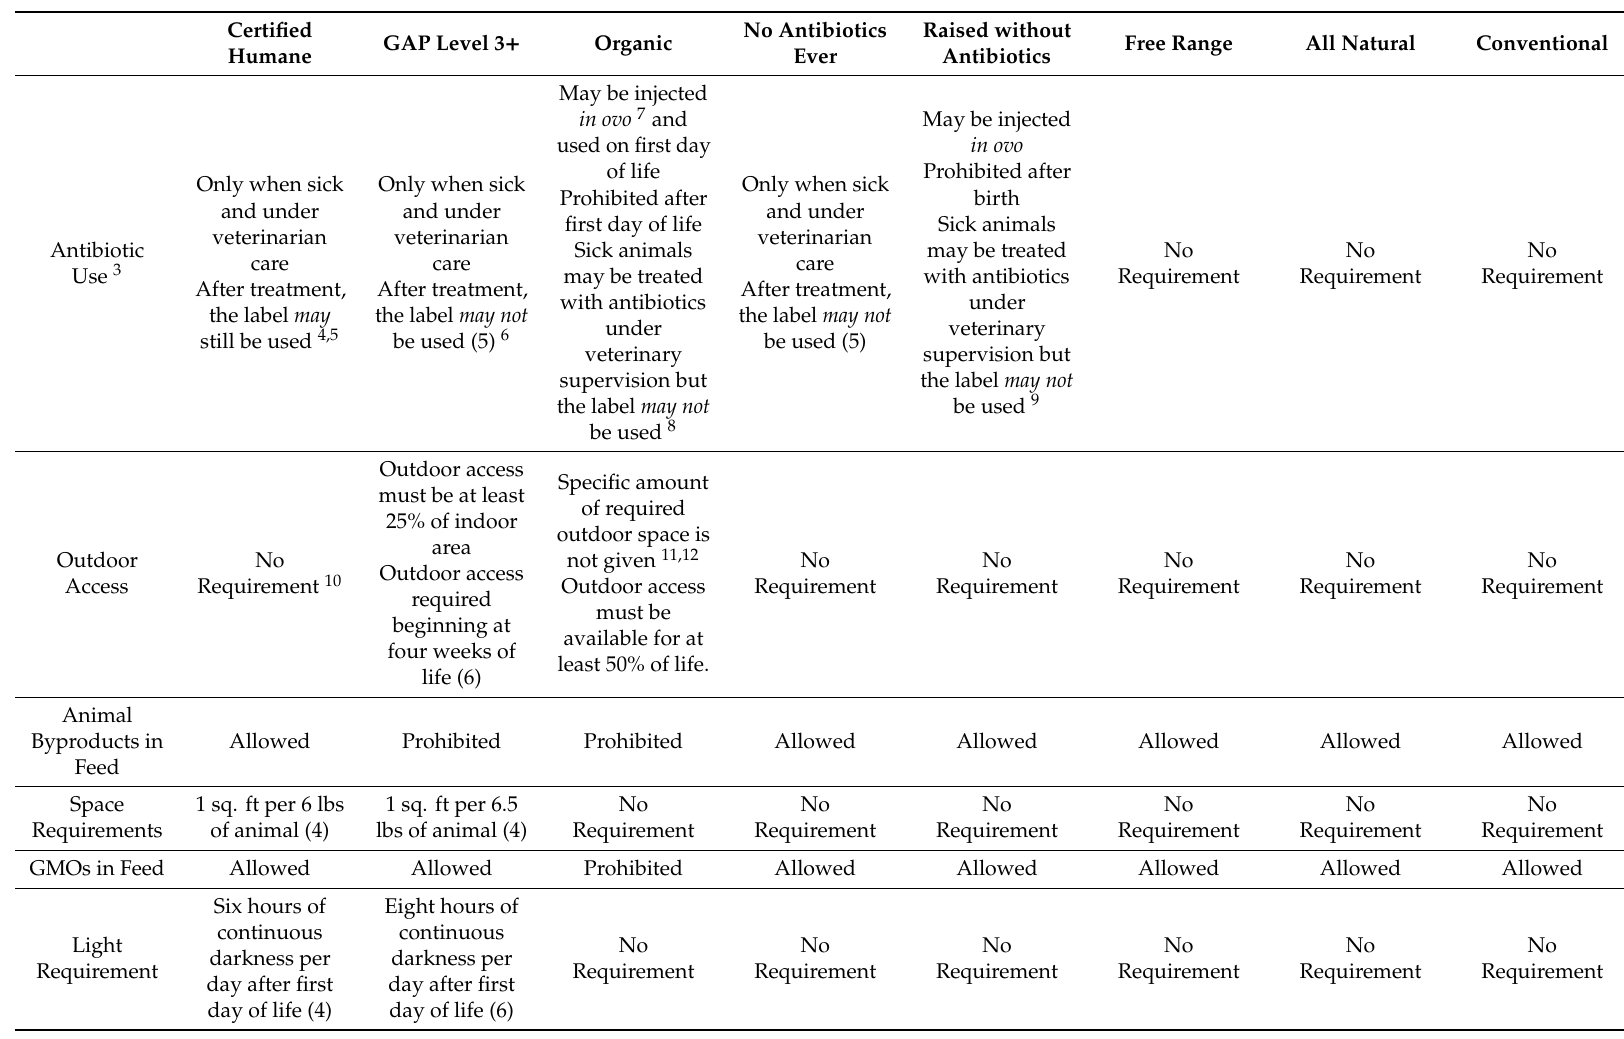
Table 1. Package labeling descriptions of antibiotic use and humane standards on the retail broiler chicken in this study 1,2